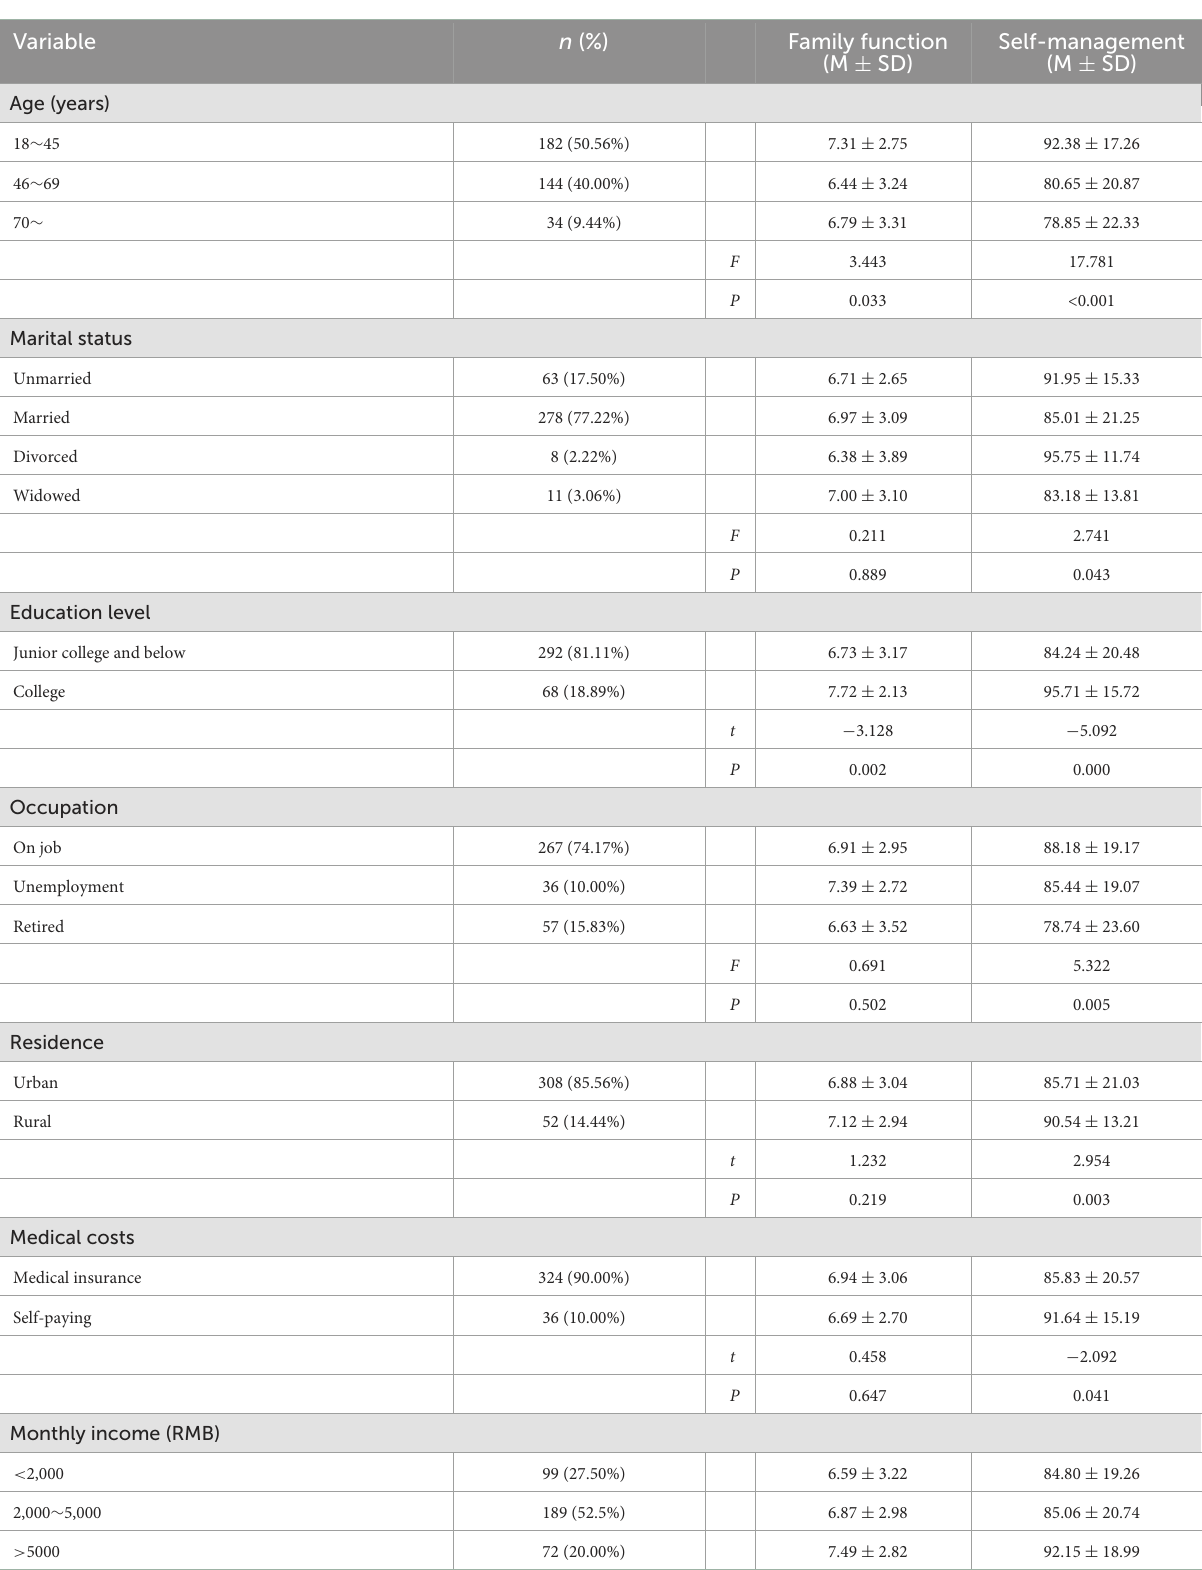
TABLE 1 Sociodemographic descriptive statistics and comparison of family function and self-management ( N = 360).